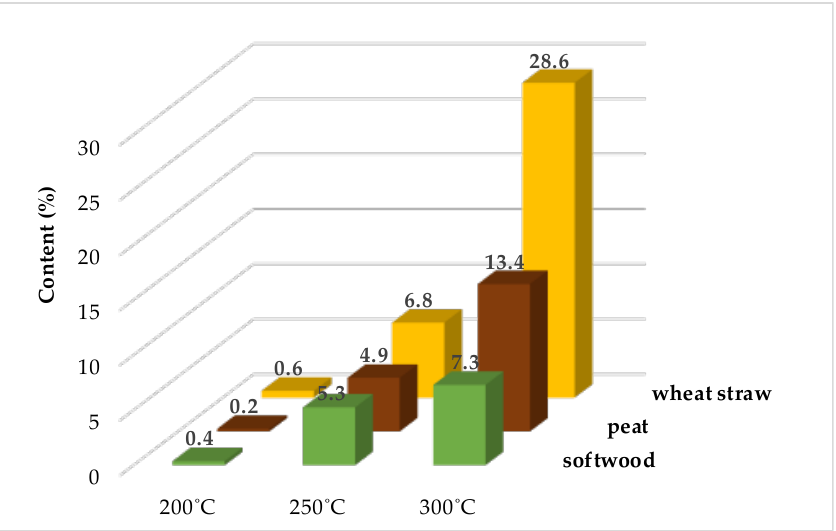
Figure 3. Yields of tar that were isolated from the condensable fractions that were obtained by MW-assisted torrefaction of different types of lignocellulosic biomass. Table 1. Content and composition of the organic substituents that were present in the water distillates that were removed from the condensable products of MW-assisted torrefaction of biomass, that were obtained at different temperatures according to the GC data.